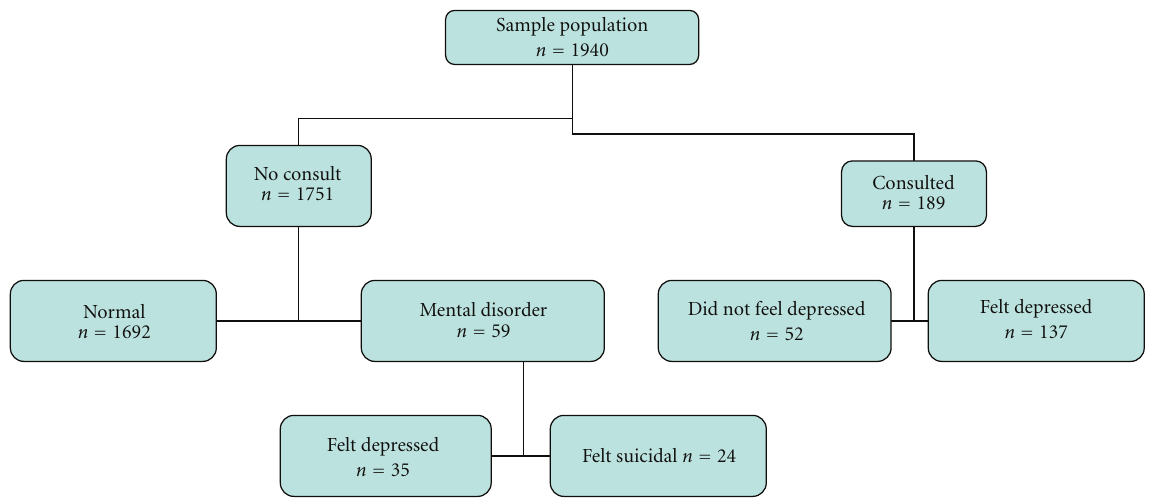
Figure 1: Diagrammatic representation of the responses of participants to the